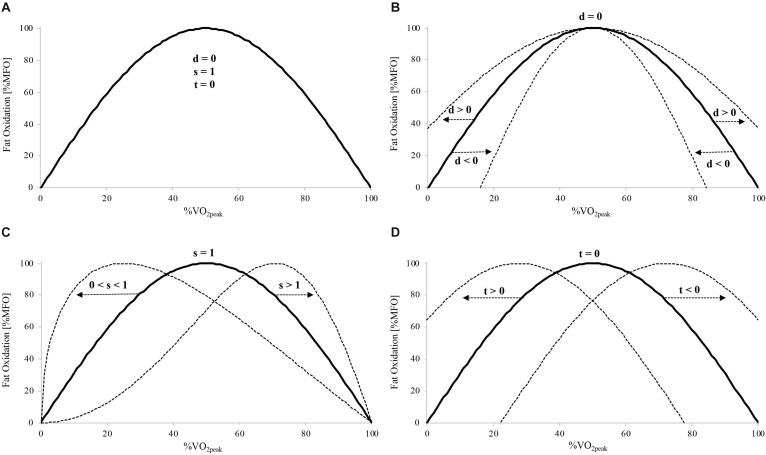
Schematic illustration of the three independent variables of the SIN model (dilatation [d], symmetry [s], and translation [t]) and their impact on the whole-body fat oxidation kinetics. Basic symmetric SIN curve with d = 0, s = 1, and t = 0 (A). Changes in d (B), s (C), and t (D) and corresponding modifications in the basic symmetric SIN curve (dotted lines). MFO, maximal fat oxidation; V.O2⁢p⁢e⁢a⁢k, peak oxygen uptake.